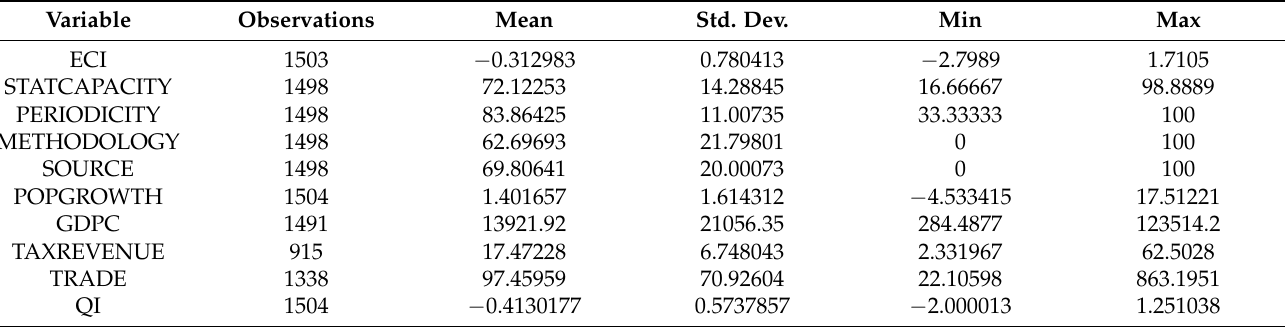
Table 2. Descriptive statistics.